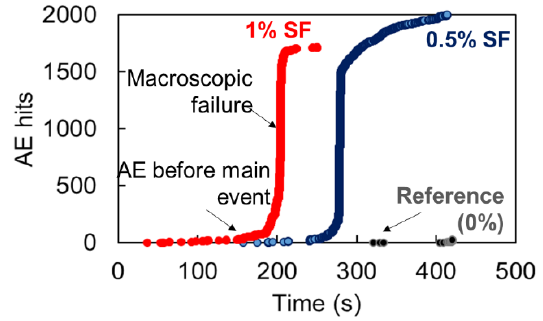
Figure 5. Cumulative AE curves for typical concrete specimens with different vol.% of steel fibers tested on three-point bending.